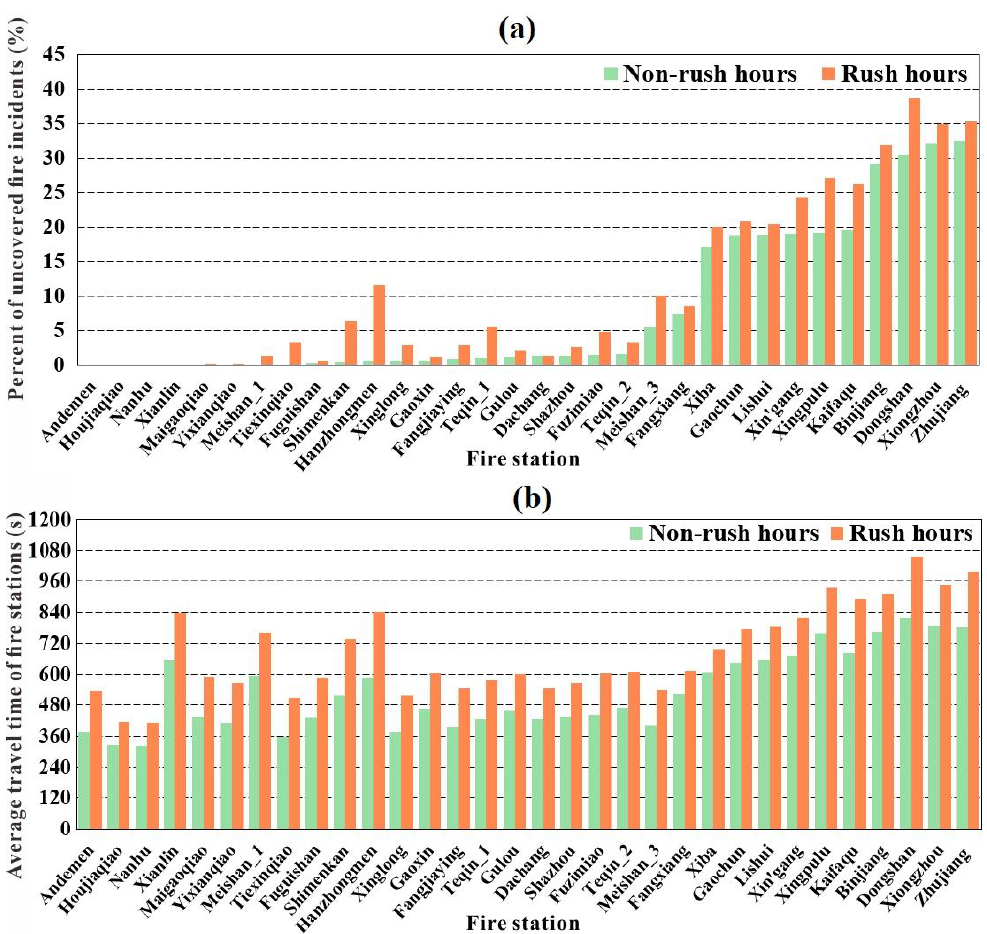
Figure 9. ( a ) Percent of uncovered fire incidents and ( b ) average travel time of fire stations in non-rush and rush hours of 1 day.